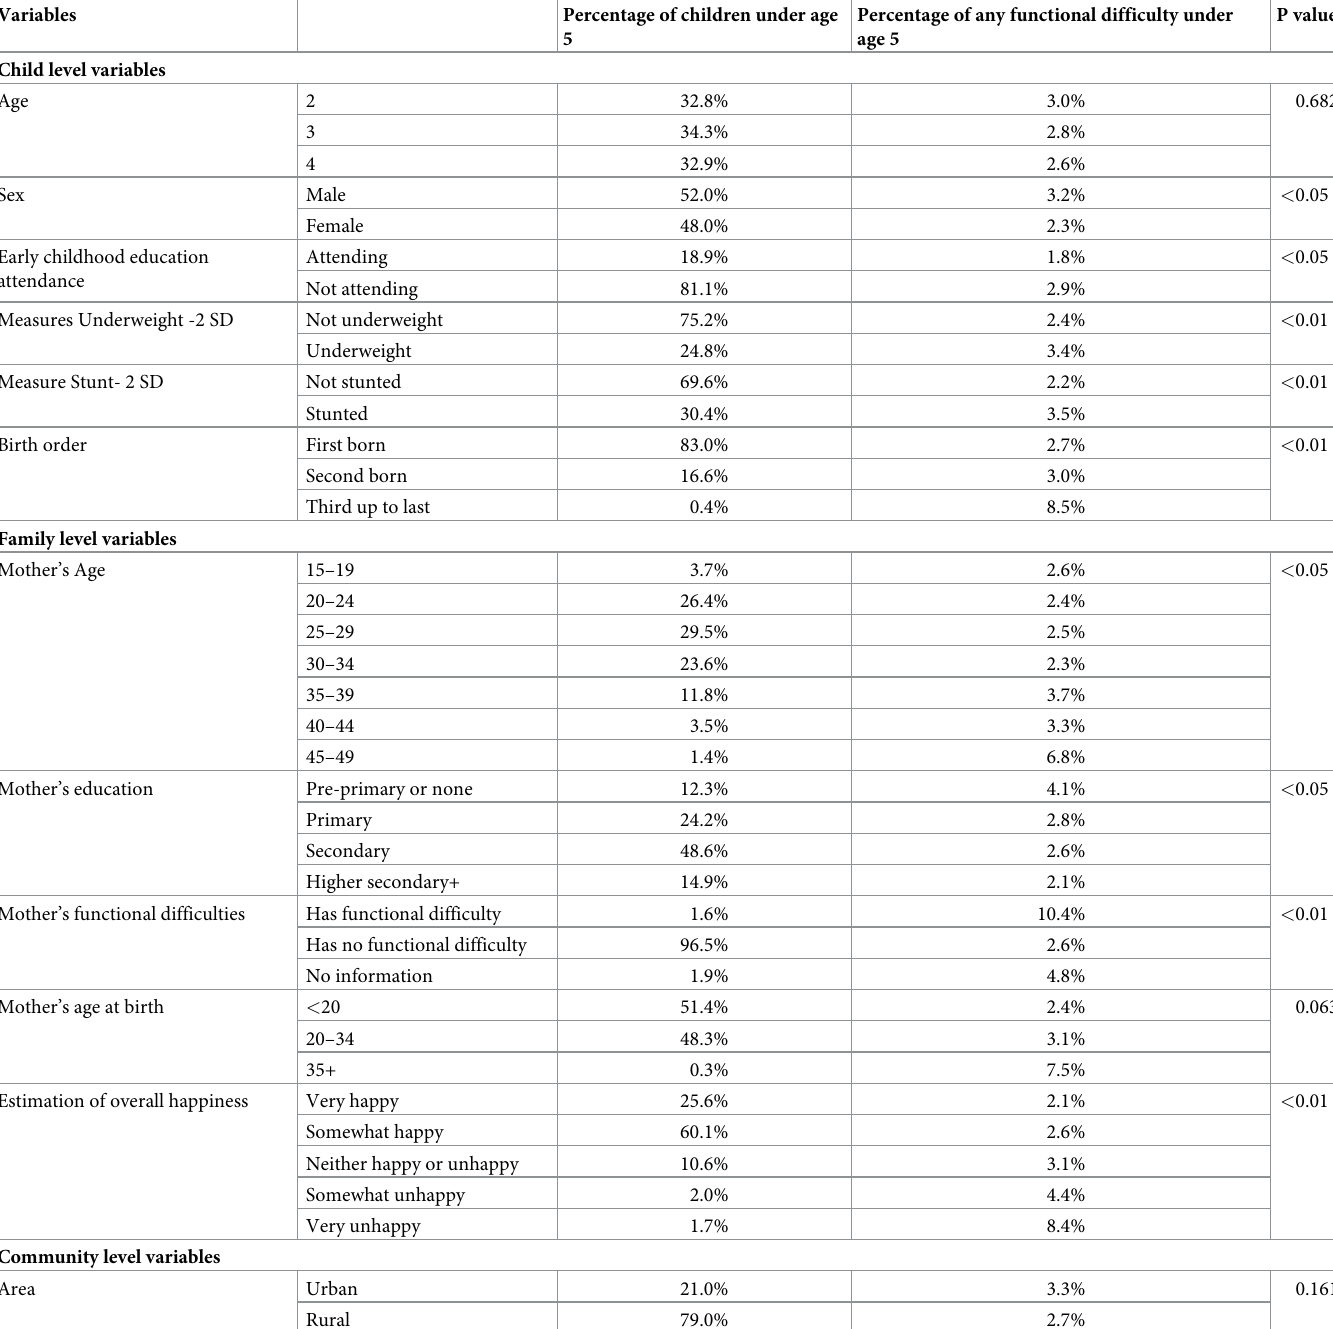
Table 1. Prevalence of childhood disability among children aged 2 to 4 years in Bangladesh (N =